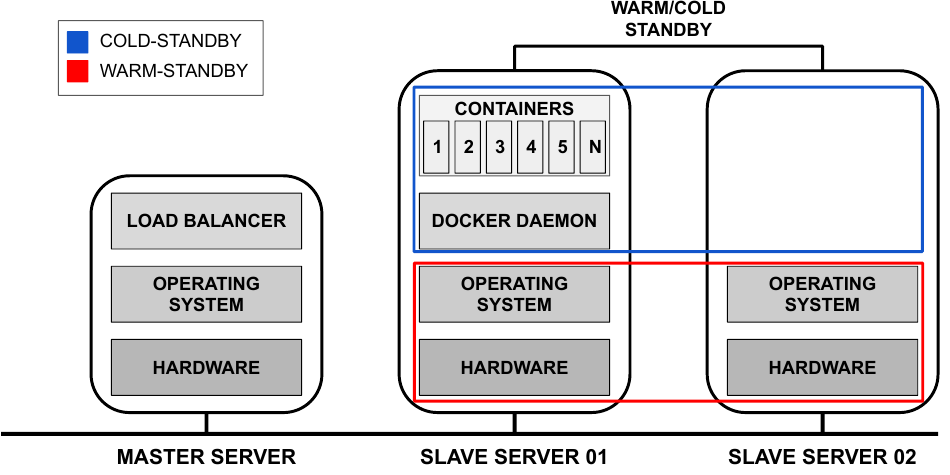
Figure 14. Layered architecture with redundancy under the slave